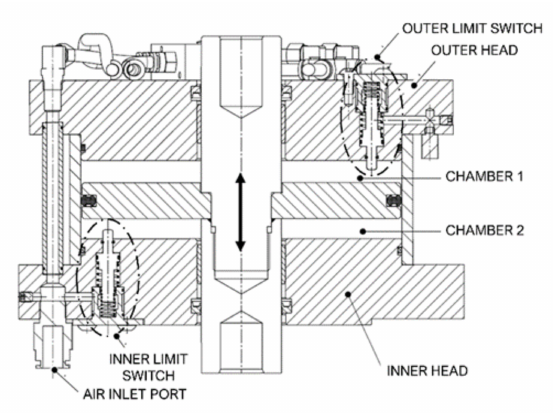
Figure 4. Section view of the pneumatic